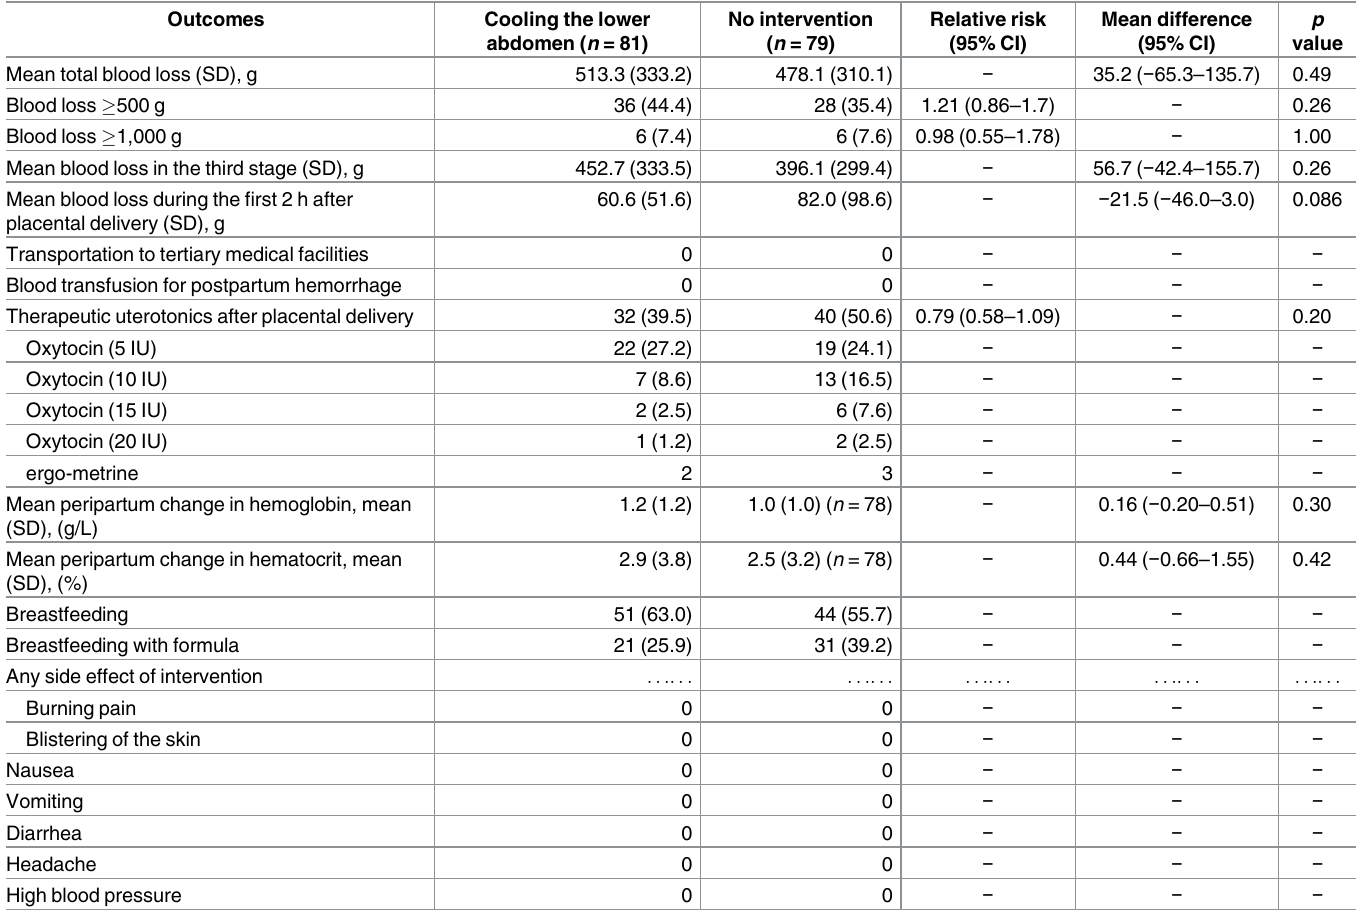
Table 2. Trial outcomes by intention-to-treat analysis.